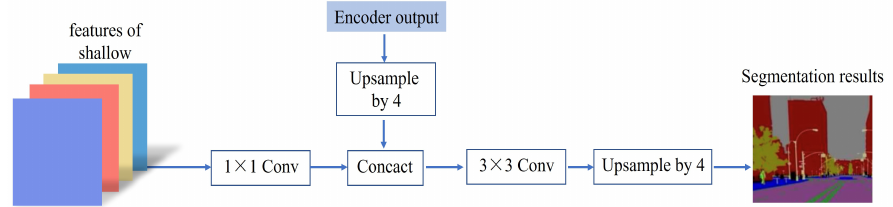
Figure 9. The structure of the